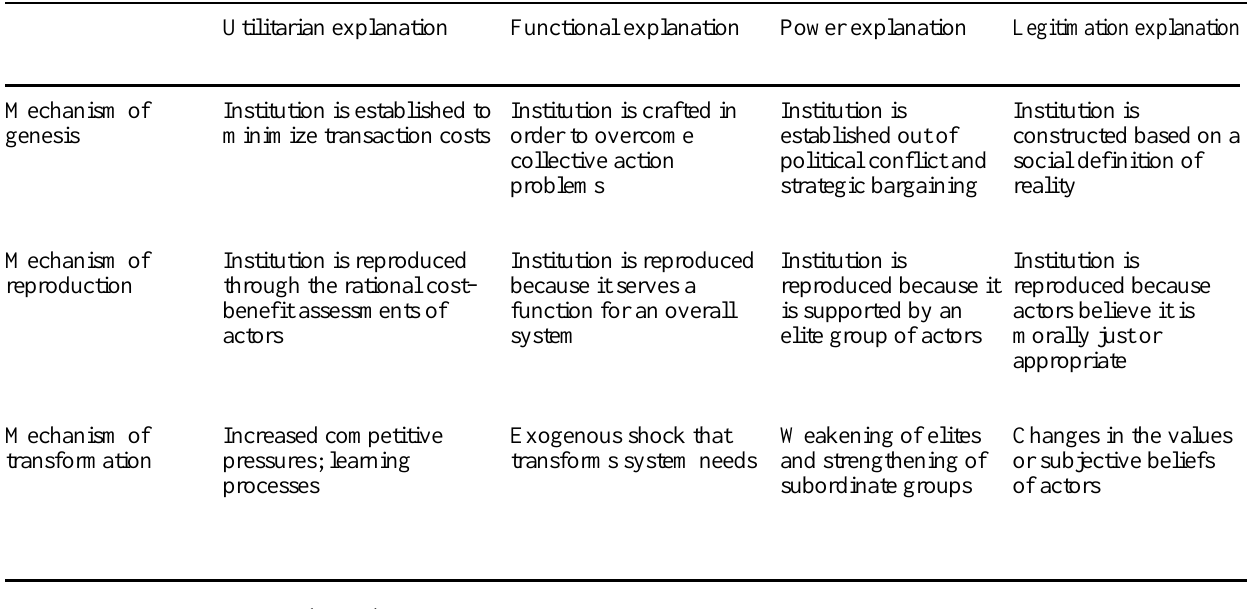
Table 1. Typology of possible explanations for institutional